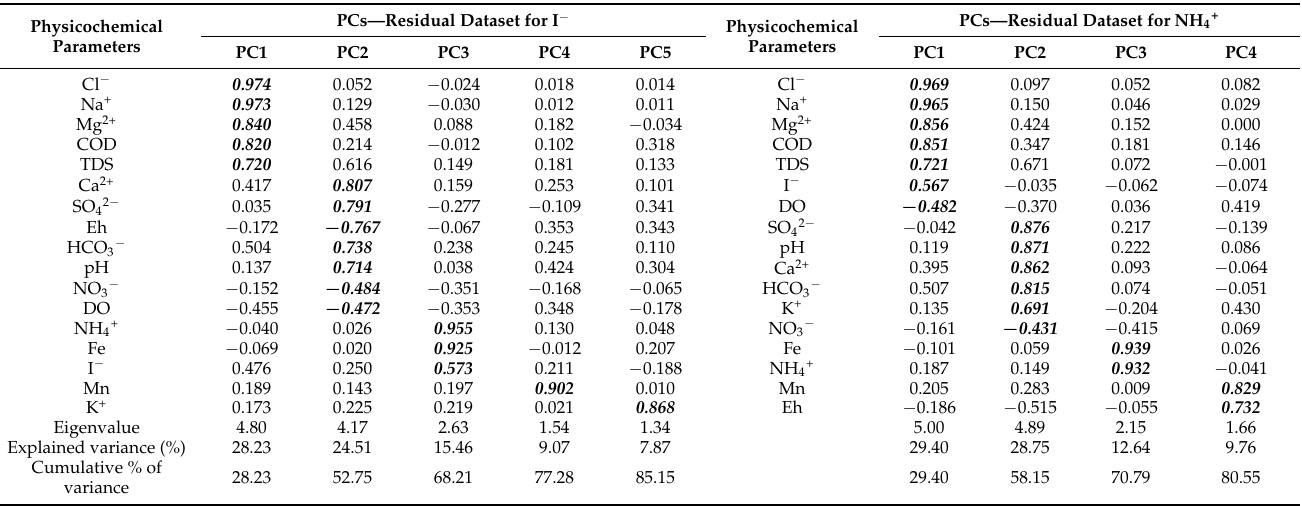
Table 3. Principal component (PC) loadings for groundwater physicochemical parameters in unit A in the residual